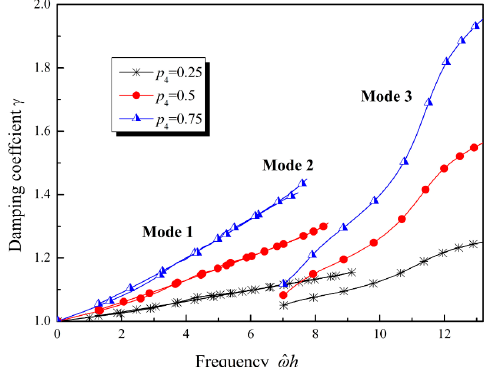
Figure 11. Damping coefficient of Lamb waves with the relative viscosity coefficient varying.